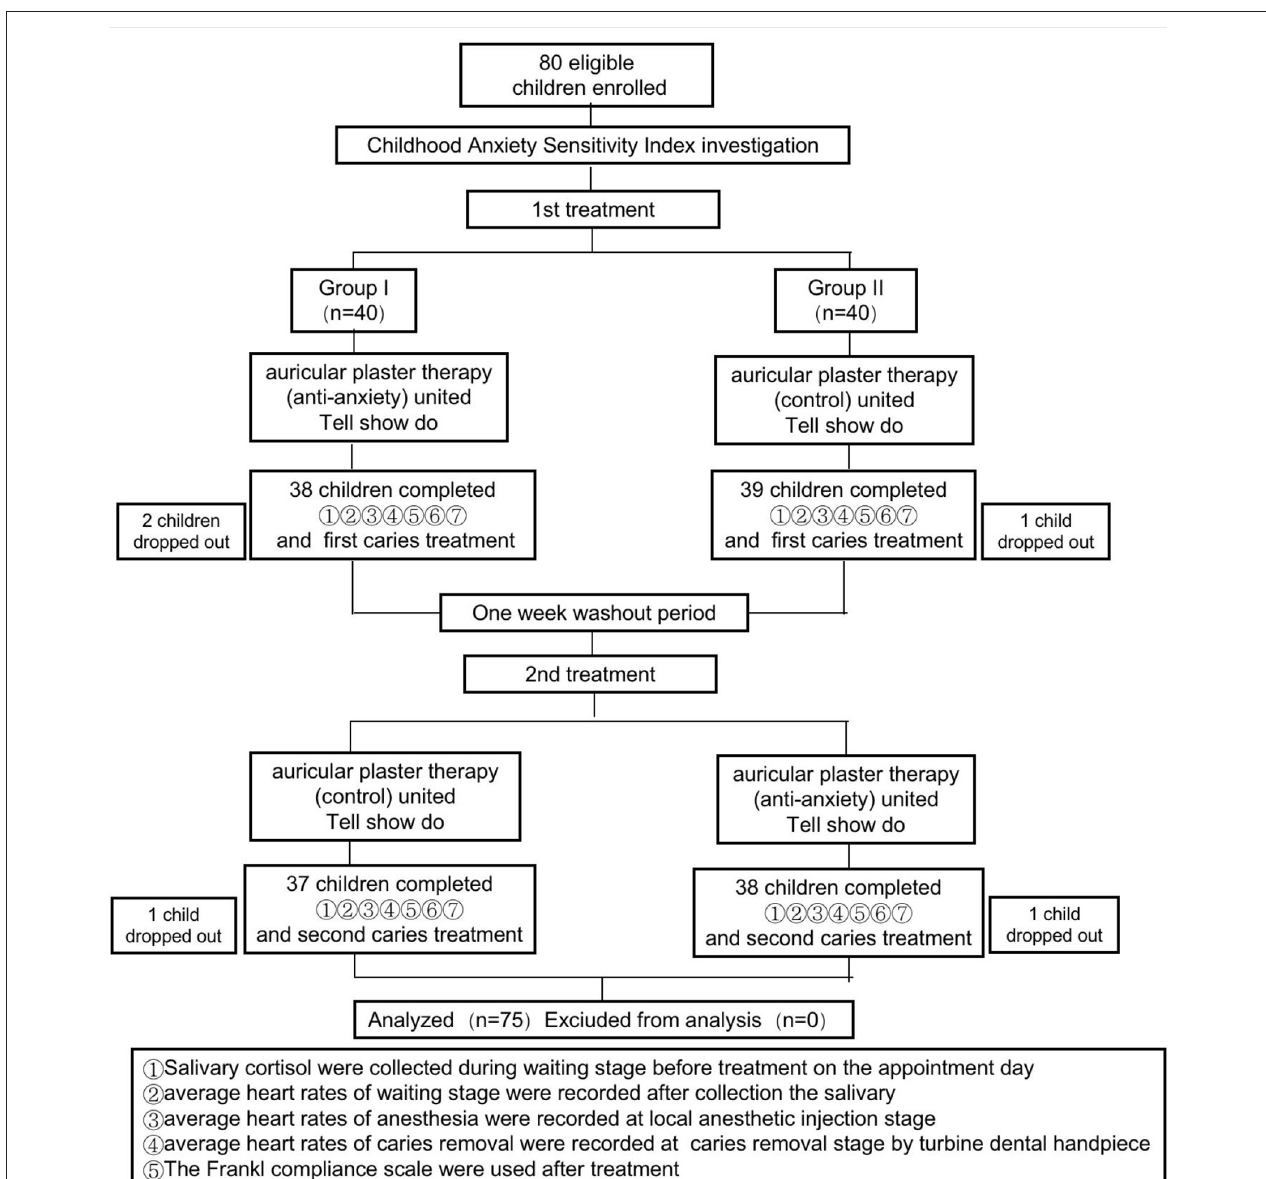
FIGURE 1 | A flowchart showing the treatment schedule and patient retention.